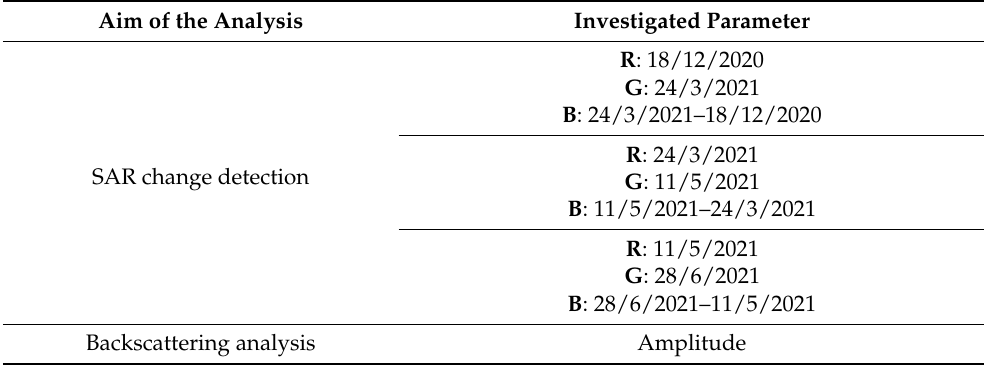
Table 3. Information about the COSMO-SkyMed SAR images and their use in the morphological evolution analysis, with the date of related